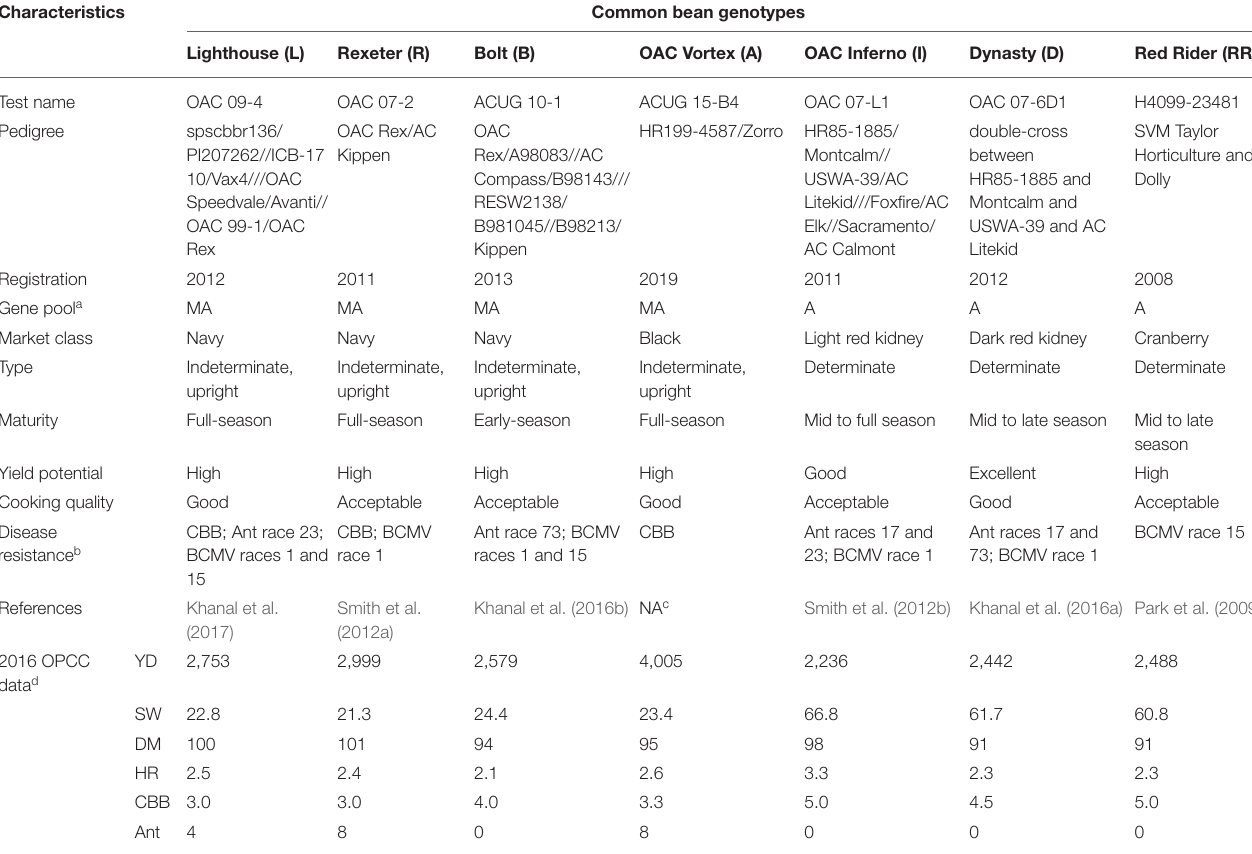
TABLE 1 | Characteristics of seven common bean genotypes selected for the mixture study conducted at two Ontario locations in 2017 and